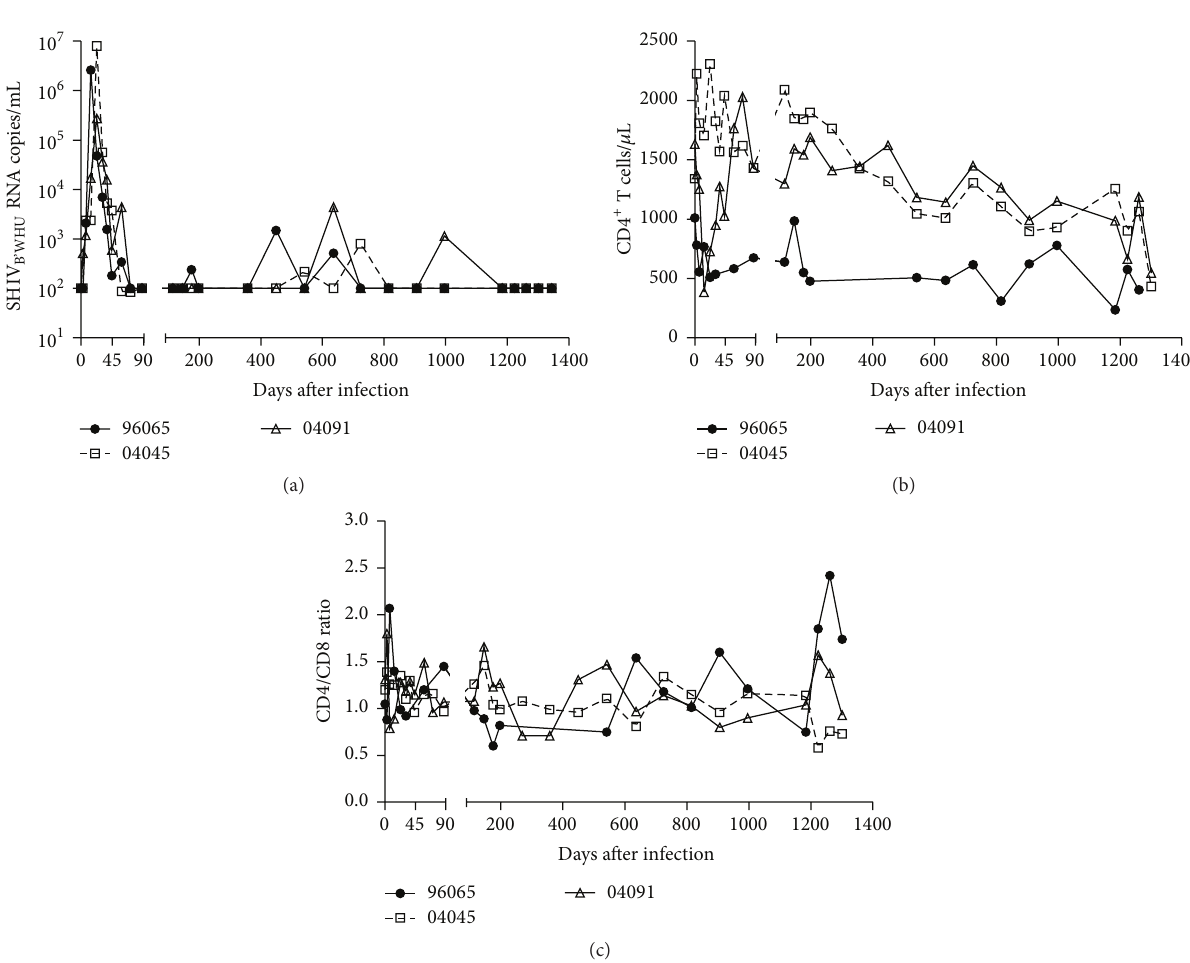
infection in Ch-RMs. (a) Viral replication. The dashed line B’WHU